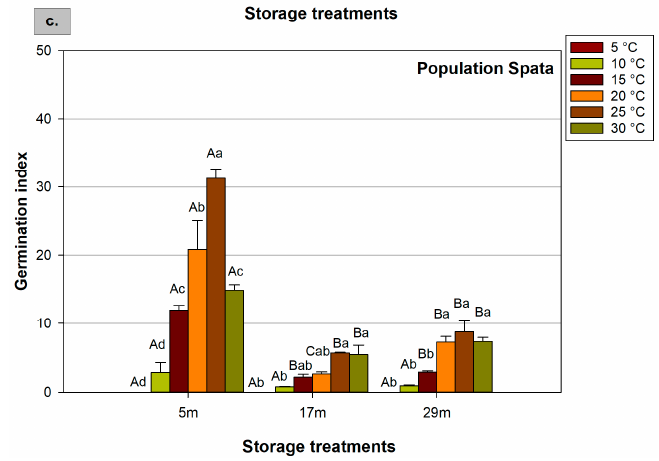
Figure 3. Effect of population (( a ) Palaionterveno, ( b ) Mesopotamia, and ( c ) Spata), storage (duration and conditions: 5, 17, and 29 refer to the months (m) of storage and the conditions that prevailed during storage), and temperature (5 ◦ C, 10 ◦ C, 15 ◦ C, 20 ◦ C, 25 ◦ C, and 30 ◦ C) on milk thistle seeds’ germination index. Capital letters show significant differences between storage treatments at the same temperature, while small letters show significant differences between temperatures at the same storage treatment. The bars represent the standard error of the means.